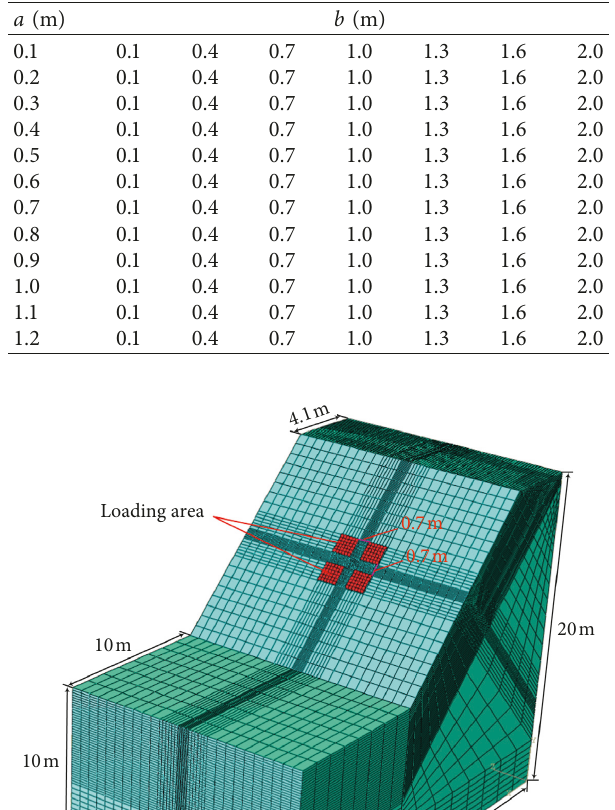
Figure 22: Zone with higher stress in a railway embankment. Table 6: FEA cases.